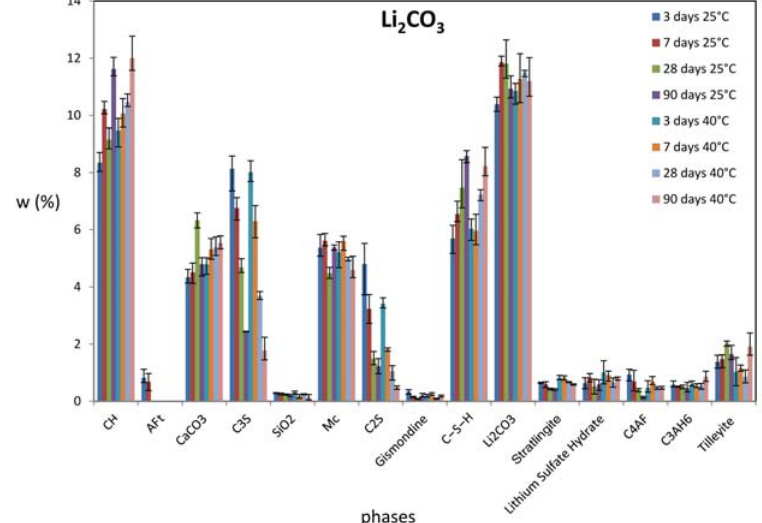
Figure 7. The quantitative analysis of hydration products in cements with added Li 25 and 40